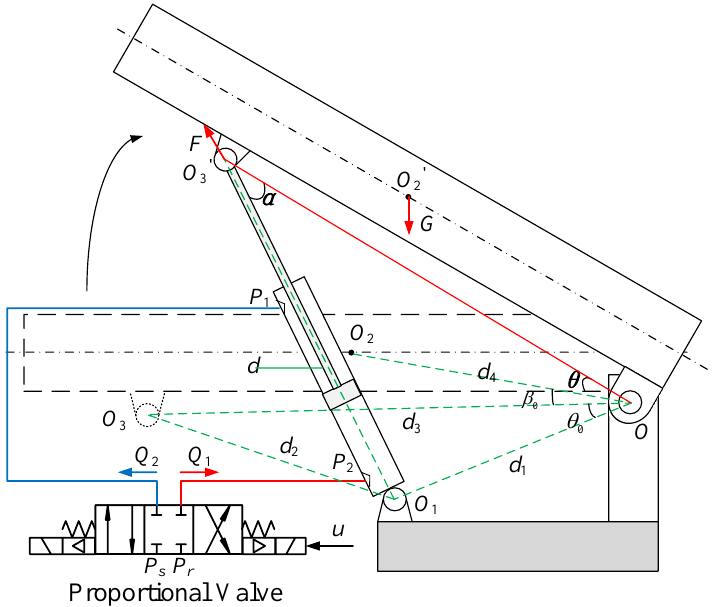
Figure 1. The schematic diagram of the lifting mechanism.